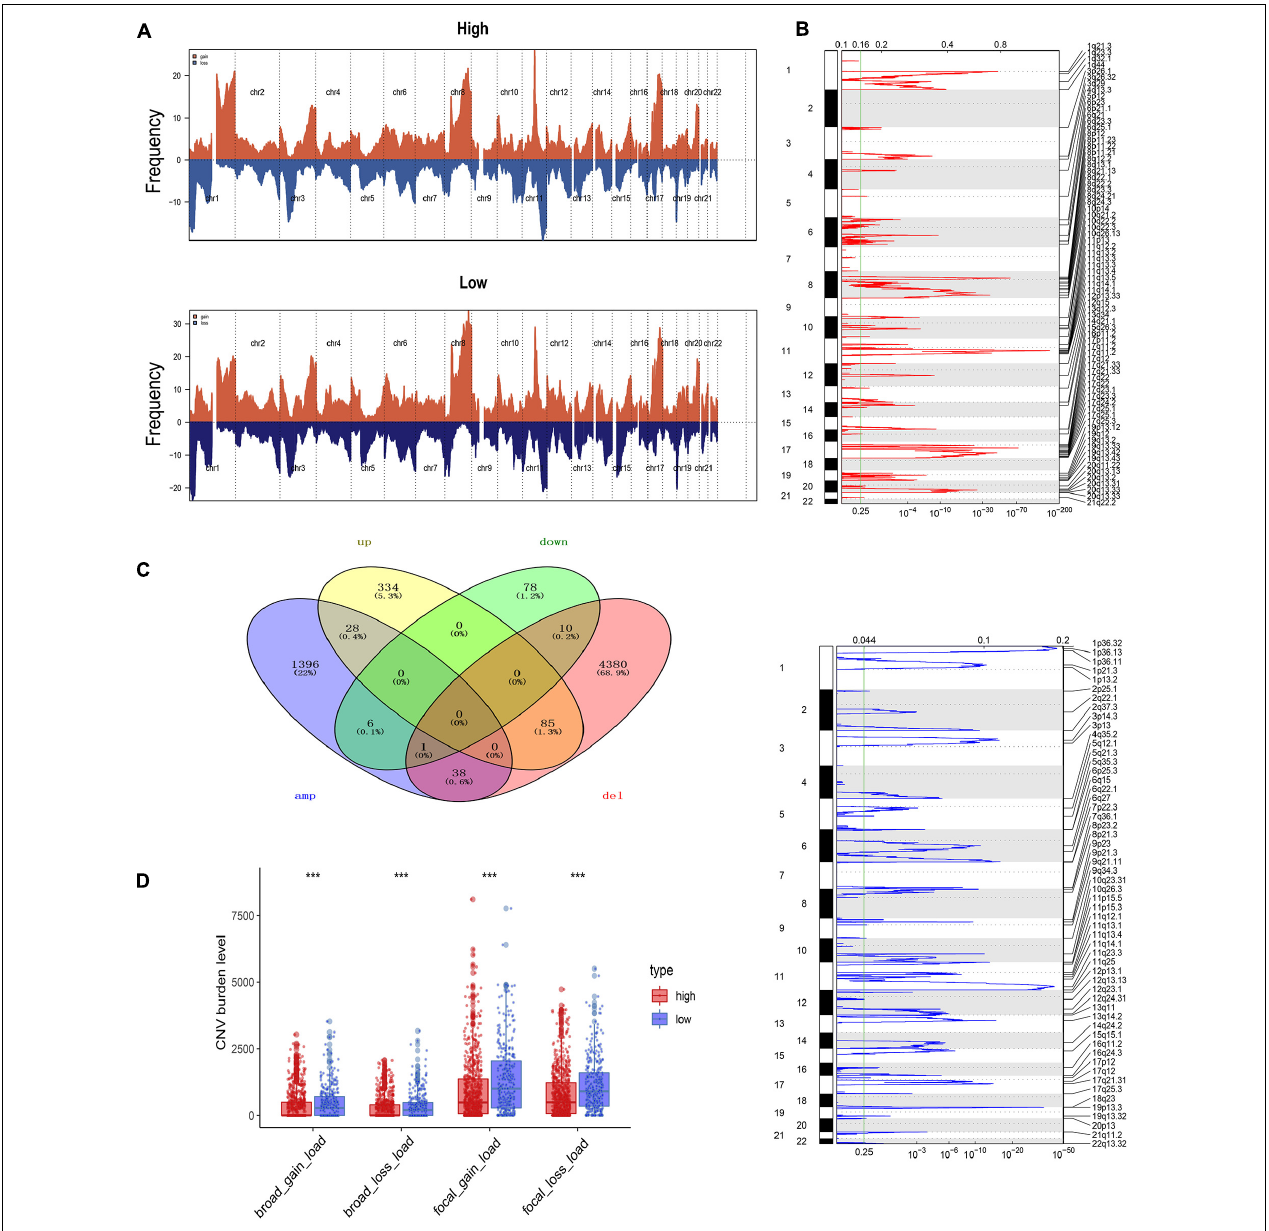
FIGURE 5 | Somatic copy number aberration across the pDC groups. (A) The copy number amplifications and deletions between the two groups. (B) Detailed cytoband with focal amplification (top) and focal deletion (bottom) in the pDC high group generated with GISTIC_2.0. (C) Venn diagram of the genes with SCNA and the DEGs in the pDC high group. (D) The burden of SCNA between the pDC high group and the pDC low group. The meaning of the statistical difference is as follows: *** represents p ≤